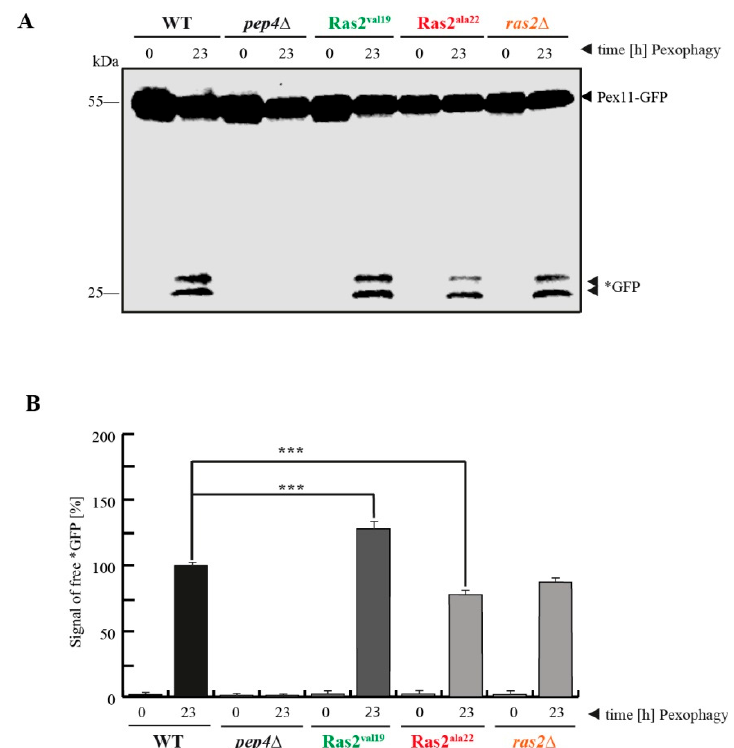
Figure 2. Ras2 ON supports pexophagy. ( A ) The impact of the Ras2 activity mutants on pexophagy was analyzed. Pexophagy was induced by shifting cells that had grown on glucose-free oleate medium (where peroxisomes are essential for viability) to a glucose-containing medium (where peroxisomes are not essential) with reduced nitrogen concentration (for the inhibition of mTOR). In wild-type (WT) cells, the Pex11-part of the fusion protein gets degraded in the vacuole with the rest of the peroxisome, while the GFP-portion stays largely stable (*GFP). This process is inhibited in the negative-control pep4 Δ . The amount of free *GFP is elevated in Ras2 ON (Ras2 val19 ) cells, while it is reduced in Ras2 OFF (Ras2 ala22 ) cells. ( B ) The *GFP antibody signals were measured via densitometry. The statistical analysis of the data ( n = 5) demonstrates that the amount of generated *GFP is significantly higher in the Ras2 ON cells and significantly lower in Ras2 OFF cells when compared to WT (***, p < 0.001). These data strongly indicate that Ras2 is required for efficient pexophagy after the shift from glucose-free oleate medium to glucose-containing pexophagy-medium.